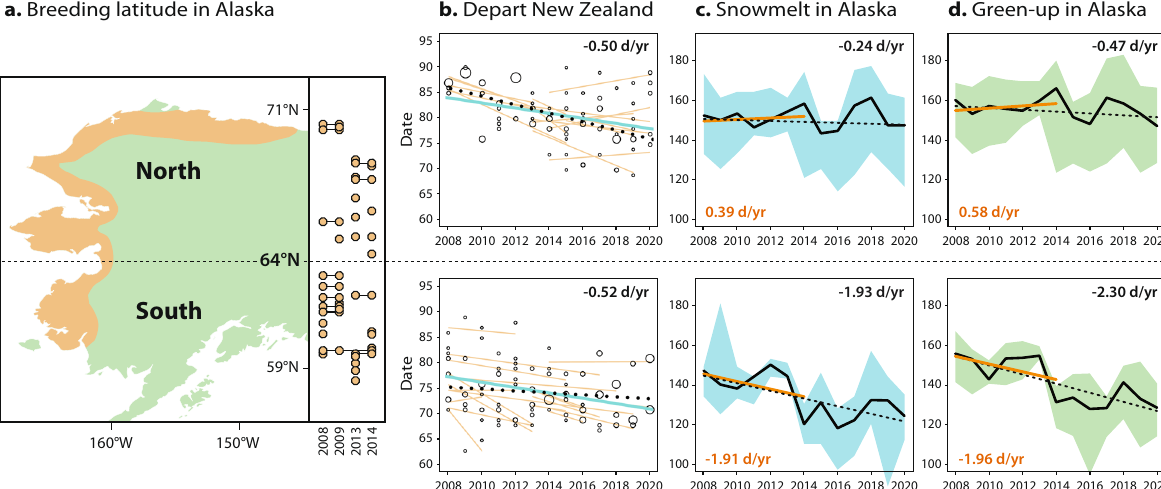
Fig. 3 Changes in the initiation of godwit migration and breeding phenology according to destination in Alaska. a Breeding latitude of 36 geolocator- tracked individuals (orange dots; lines indicate individuals tracked in multiple years) in four years of tracking (2008, 2009, 2013, 2014; n = 12 – 13 per year), and assigned to Alaska region (North >64°N, n = 16; South <64°N, n = 20). The known breeding range is shown in orange. Map made with Natural Earth. b Within- and between - individual advancement of directly observed departure date from New Zealand during 2008 – 2020 for individuals with known breeding locations in northern (upper; n = 15 individuals observed in 3 – 13 years each) and southern Alaska (lower; n = 19). Date: 1 = 1 January. Figure details as described in Fig. 2b. The within-individual slope is indicated in the panel (see Supplementary Table 1b). c Timing of snowmelt (date when 33% snow-free) in the Alaska breeding range north (upper) and south (lower) of 64°N. d Start of spring green - up (date of greatest increase in Normalized Difference Vegetation Index, NDVI) in the Alaska breeding range north (upper) and south (lower) of 64°N. For c and d , black lines indicate median date across region, and shaded areas indicate 95% quantile range. Dotted lines indicate the 13-year trend (2008 – 2020; slope indicated in the panel), and orange lines indicate the trend during the period of geolocator-tracking (2008 –